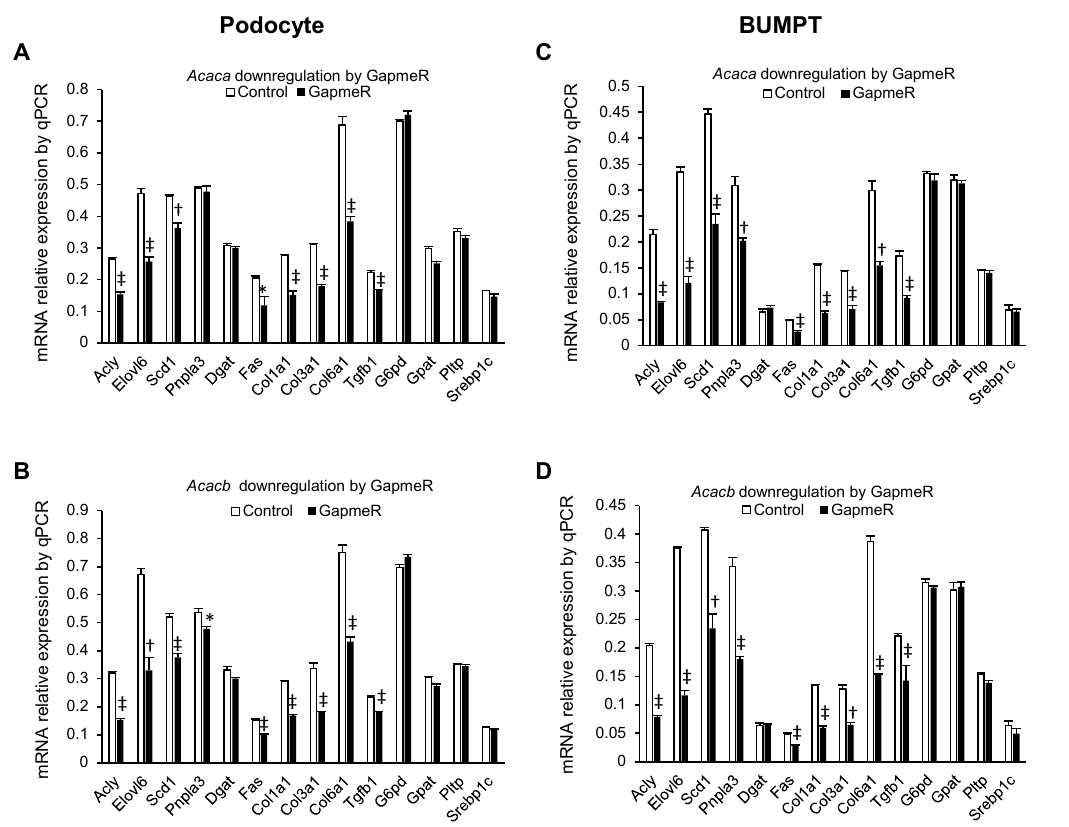
Figure 5. Comparing mRNA relative expression of gene markers in podocytes ( A , B ) and BUMPT cells ( C , D ) exposed to Acaca and Acacb GapmeRs (2 uM) compared with the negative control group. Values are mean and standard error in triplicate. * p < 0.05, † p < 0.01, ‡ p < 0.001. Number of experiments is 3 in all panels.